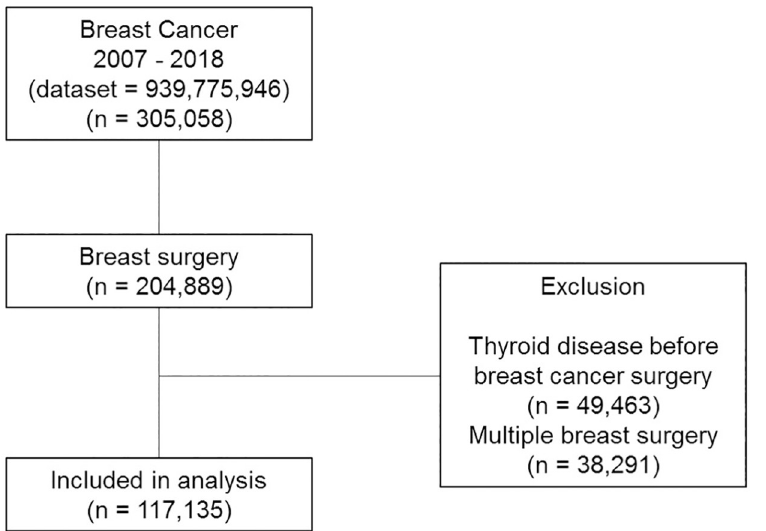
Fig 1. Process for inclusion and exclusion of patients in the